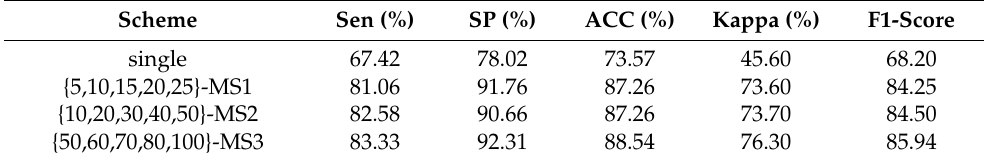
Table 5. The effect of multi-scale ROIs on the CBIS-DDSM test performance.